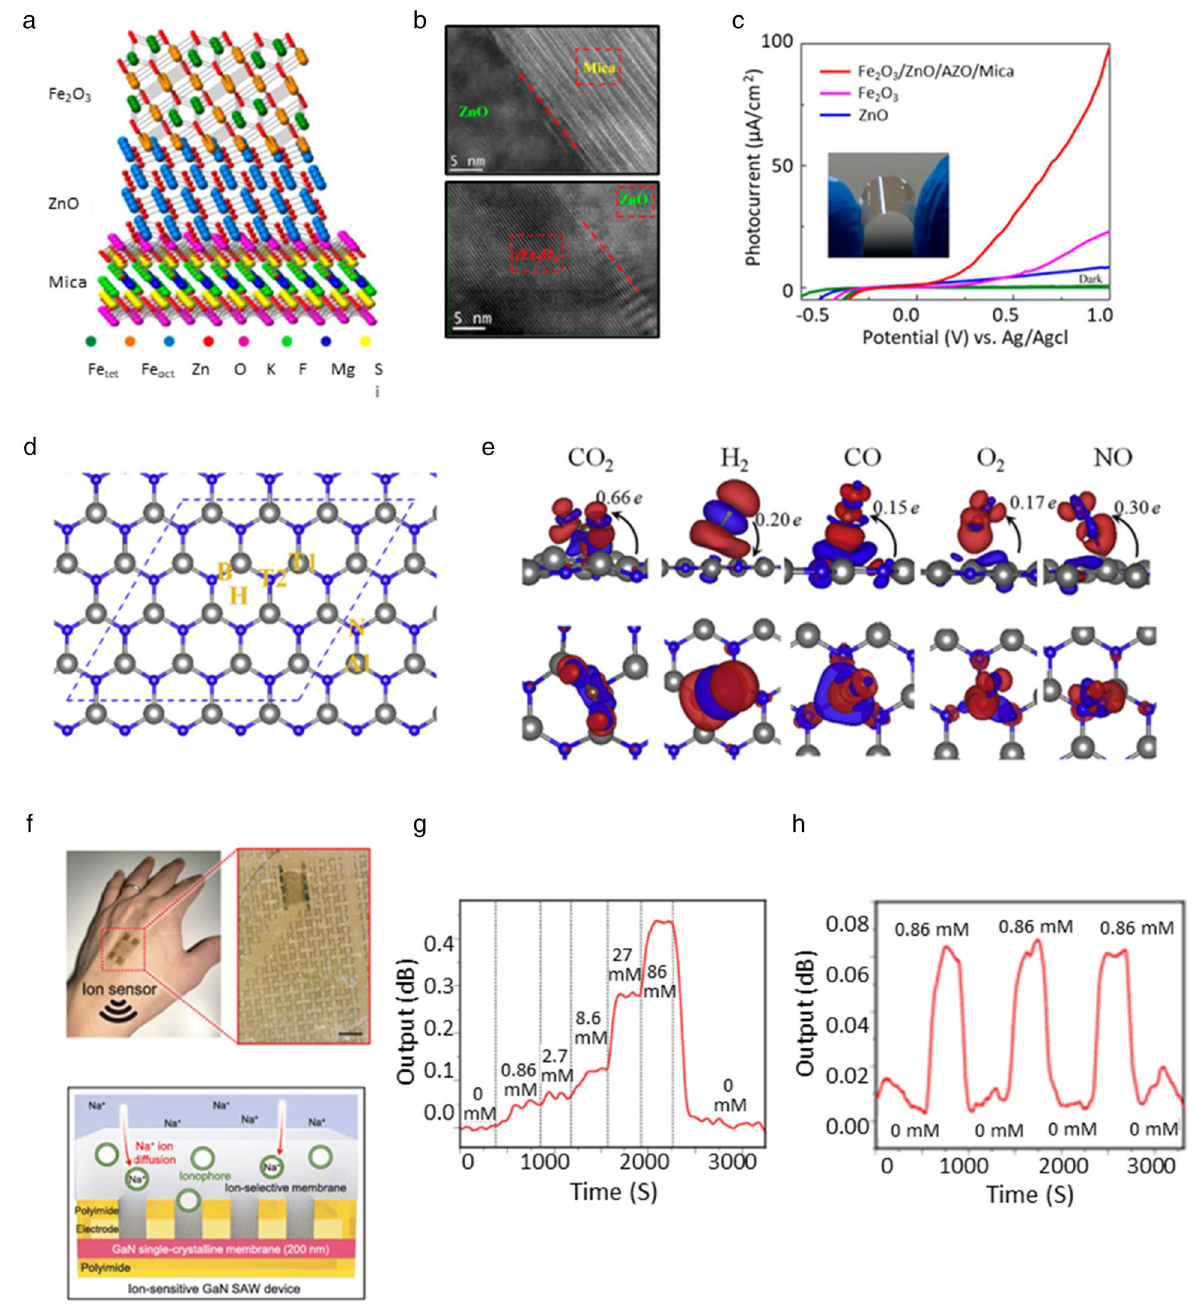
Fig. 5 a . Structural schematic of the Fe 2 O 3 /ZnO/mica heteroepitaxy, b . Cross‑sectional TEM image of the ZnO/mica and Fe 2 O 3 /ZnO interface, c . Linear‑sweep voltammograms of pure Fe 2 O 3 , ZnO, and the Fe 2 O 3 /ZnO electrodes with visible‑light illumination and the inset photograph of flexible Fe 2 O 3 /ZnO/mica [114], d . The atomic structure of monolayer AlN and four possible adsorption sites, e . Charge density difference plots for CO 2 /AlN, H 2 /AlN, CO/AlN, O 2 /AlN, NO/AlN [120], f . Photograph of an e‑skin attached on the back of hand (top) and Schematic illustrations and wireless ion sensors based on GaN SAW device coated with Na + ion–selective membranes, g . Resonant frequency shift in the wireless signals obtained from a GaN SAW ion sensor in response to changes in Na + ion concentration, h . Continuous wireless recordings collected from a SAW ion sensor during a series of alternating injections of 0.86 mM NaCl solution and distilled water over the e‑skin